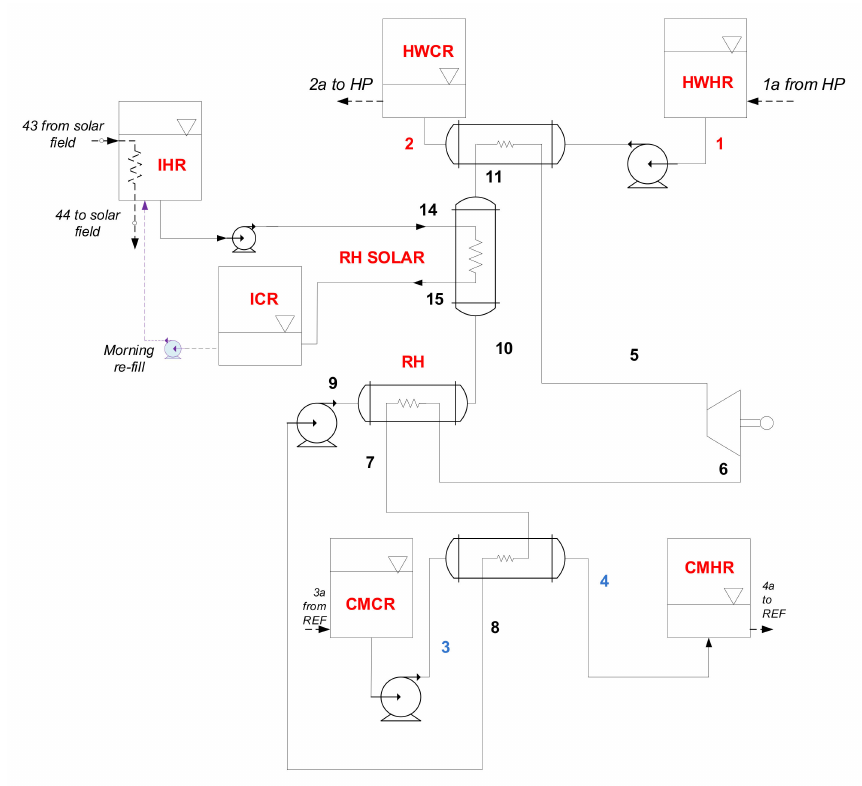
Figure 2. Scheme of the power